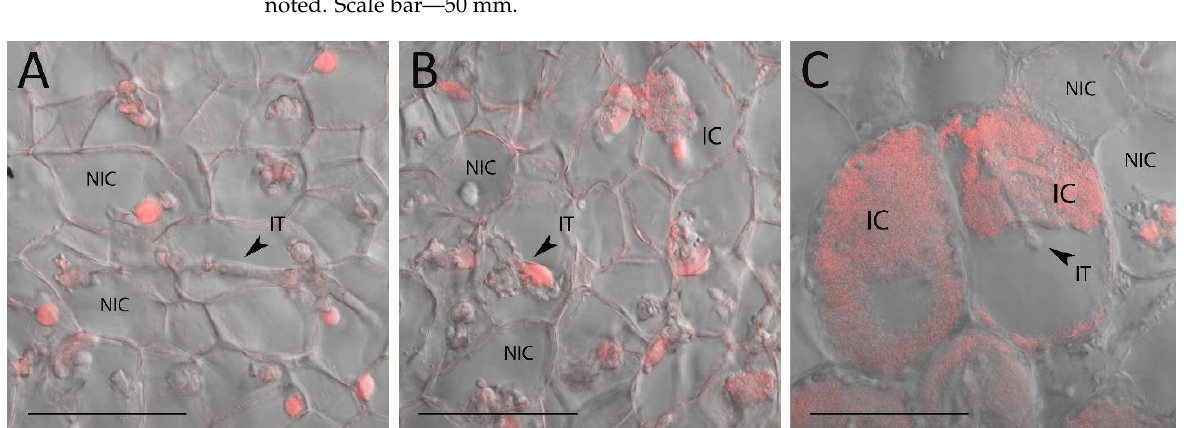
Figure 1. The root length ( A ) and number of nodules ( B ) in sym33-3 mutant plants non-treated (control, a ) or treated with increasing concentrations of cytokinin 6- BAP: 1 μM ( b ), 5 μM ( c ), 10 μM ( d ), and 15 μM ( e ). The graphs show the average values of three independent experiments. The error bars represent standard errors of the mean (SEM) of three repeats. The different letters indicate statistically significant differences based on one-way analysis of variance (one-way ANOVA), followed by Tukey post-hoc test. Nodules are indicated by white arrows. A visual increase in the size of the nodules was noted. Scale bar — 50 mm.